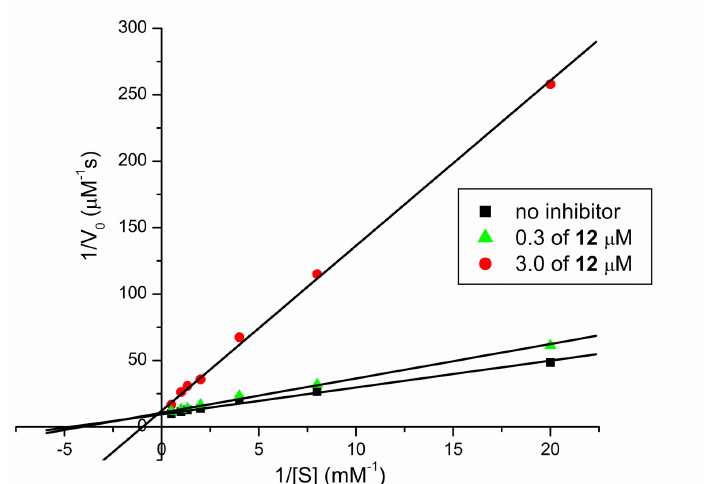
FIGURE 2 - Lineweaver-Burk plot for the inhibition of BuChE with different butyrylthiocholine concentrations (0.05 to 2.0 mM) in the absence and presence of compound 12 at concentrations of 0.3 and 3.0